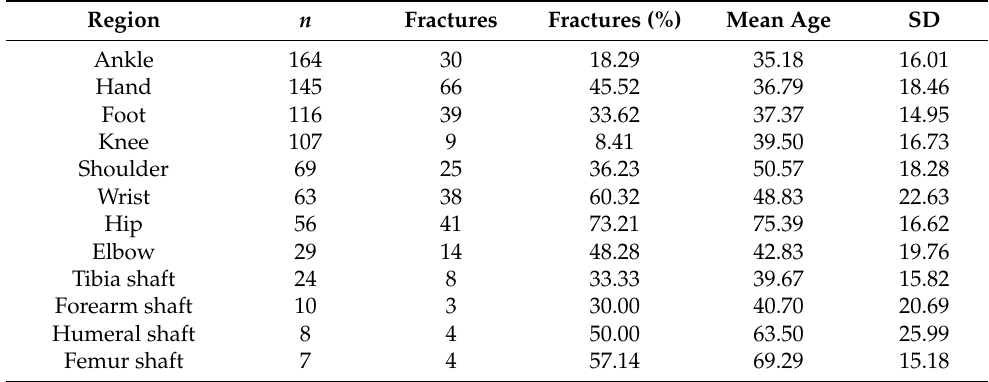
Table 1. Detailed table of the anatomic regions injured showing the number of patients, the number of fractures and percentages, the mean patient age, and the standard deviation (SD) of the mean age. The highest percentage of fractures and the highest age are highlighted (hip